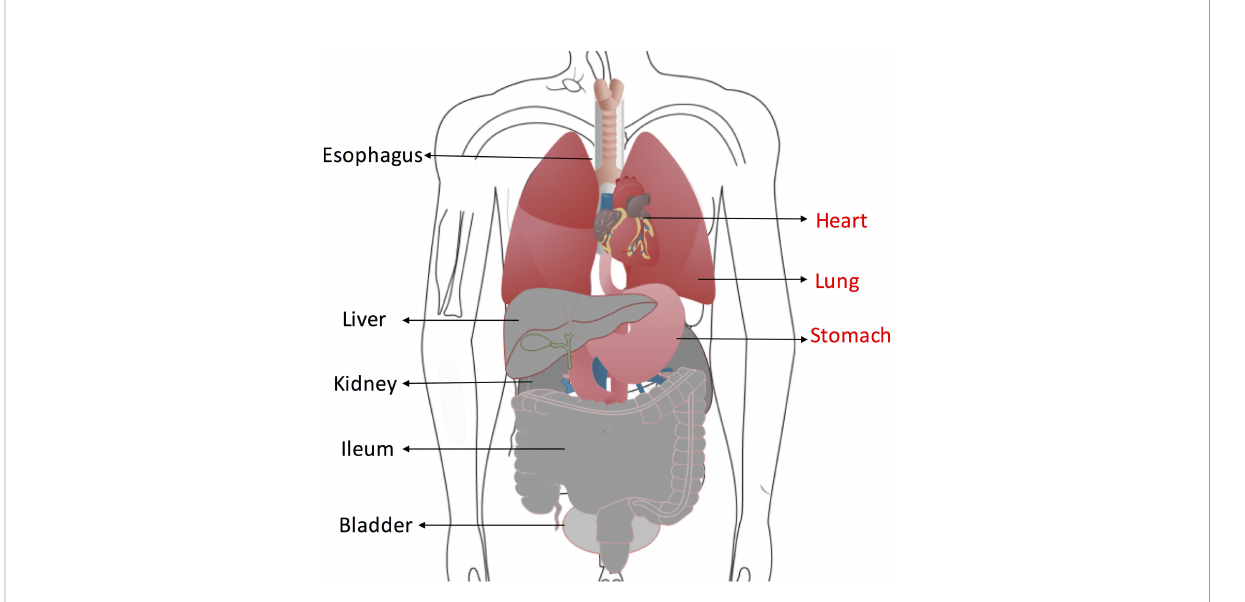
FIGURE 9 Organs at high risk of “ on-target off-tumor ” toxicity for anti-MSLN CAR T cells therapy are highlighted in red. Low-risk organs including esophagus, ileum, liver, kidney and bladder are shown in